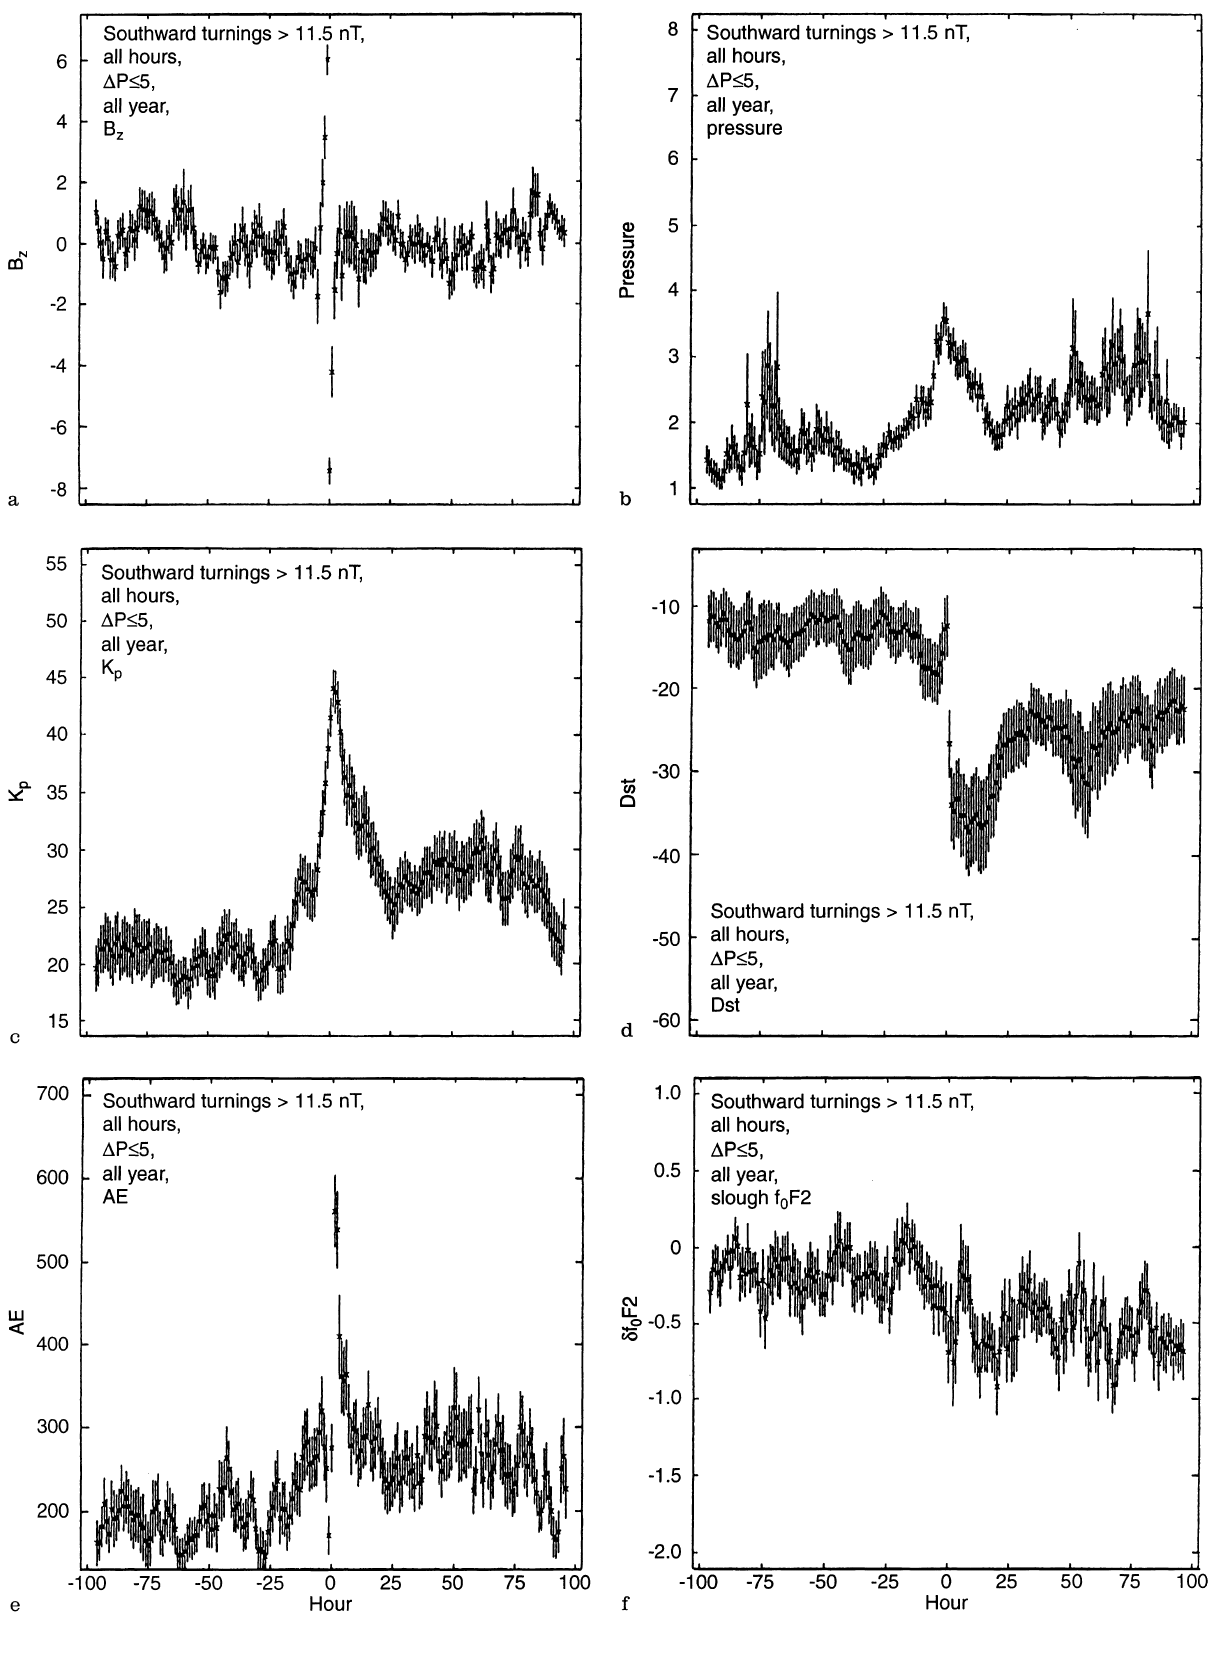
Fig. 5a–f. Same as Fig. 4, for (cid:100) B z > 11.5 nT and P £